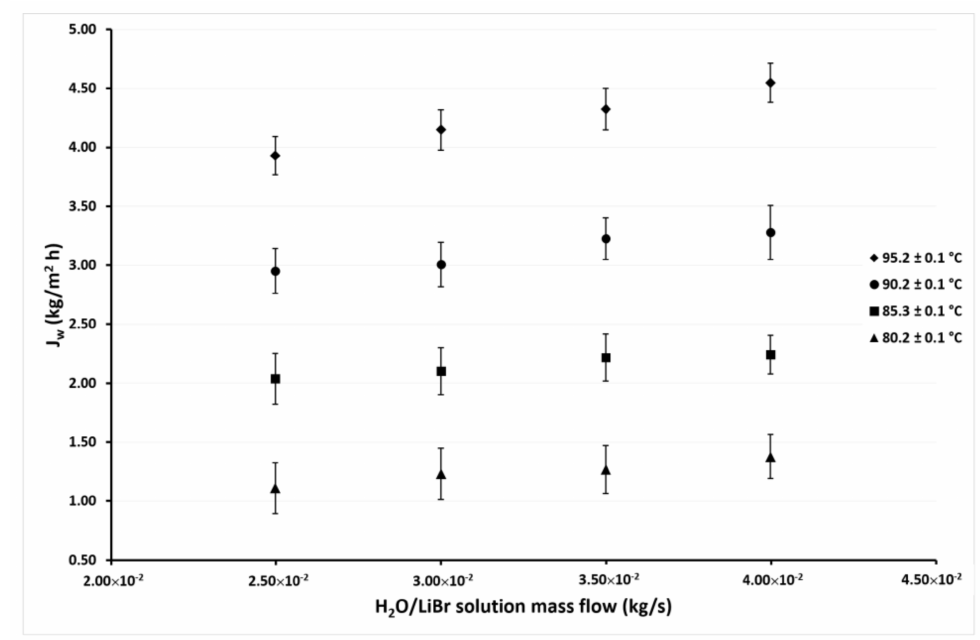
Figure 5. Desorption rate as a function of the ˙m LiBr with T cw,in = 45.1 ± 0.1 ◦